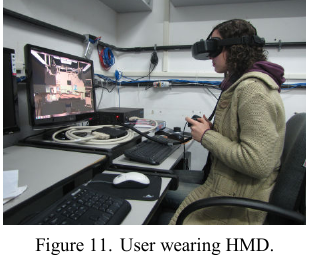
Figure 11. User wearing HMD.